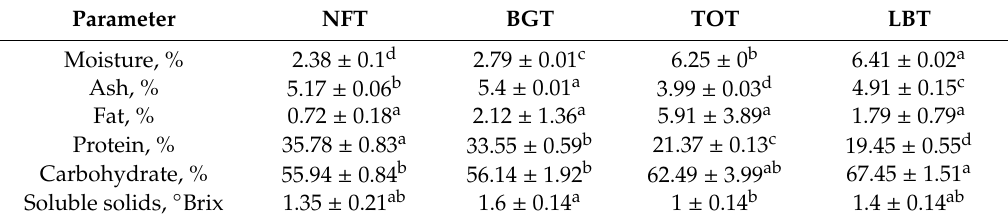
Values are the means ± standard deviation of triplicate determinations. Means with the di ff erent letters (a, b, c, or d) in the same row are significantly di ff erent at p < 0.05. NFT, novel fermented tea; BGT, Boseong green tea;